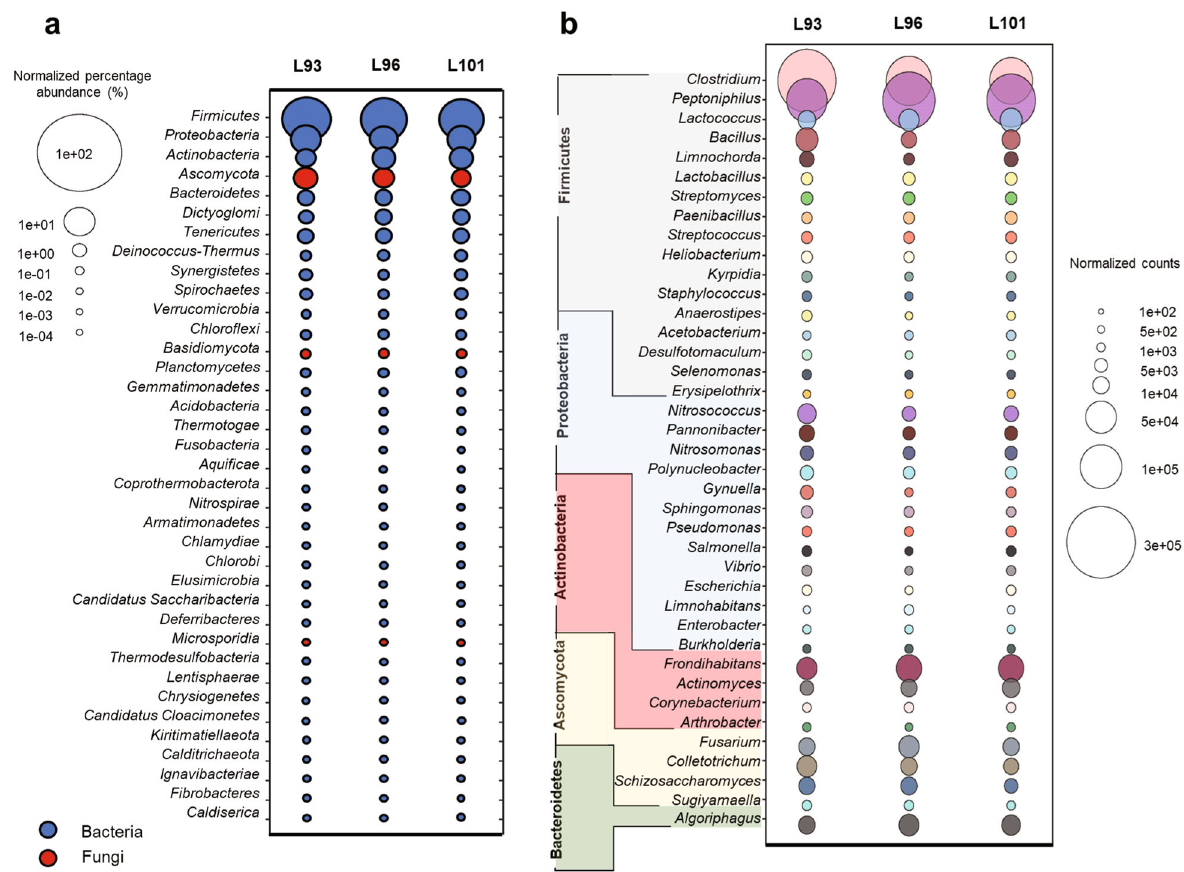
Fig. 2 Taxonomy diversity of 16S and 18S rRNA reads in the leaf metatranscriptome samples analyzed by Kraken2. a Normalized percentage abundance of all bacterial and fungal phyla within each sample. Unclassi fi ed and Cyanobacteria were not included in the bubble plot. Bubble colors for each phylum that belong to bacteria and fungi are indicated by blue and red bubbles, respectively. The size of the bubble indicates the normalized percentage abundance of each phylum. b Bubble plots illustrating the normalized counts of genera from the top 5 phyla with ≥ 500 normalized read counts across all three samples. The size of the bubble indicates the normalized counts for each